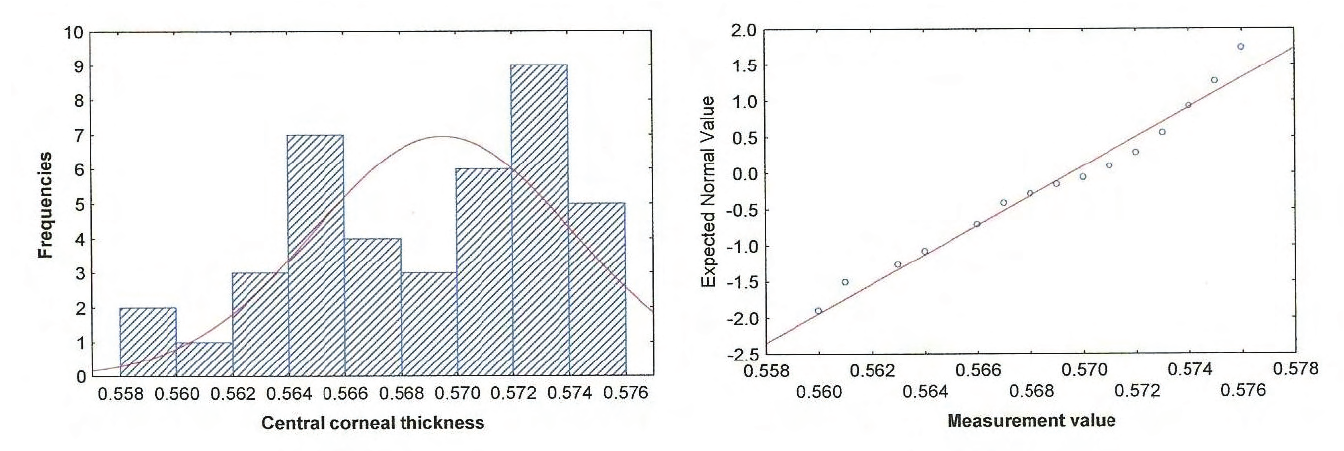
Figure 9. Histogram and normal probability plots for the CCT (a) and AACD (b) samples of subject 3. The sample for CCT (a) was approximately normally distributed (the p -values for the K-S, Lilliefors and SW-W tests were not less than 0.05 for the CCT but were less than 0.05 for the AACD ( p = 0.0023) sample in part (b) .